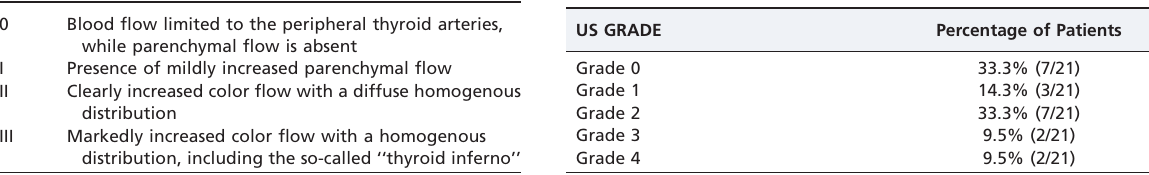
Table 2 - Color Doppler classification in hypothyroidism, by Schulz et al.